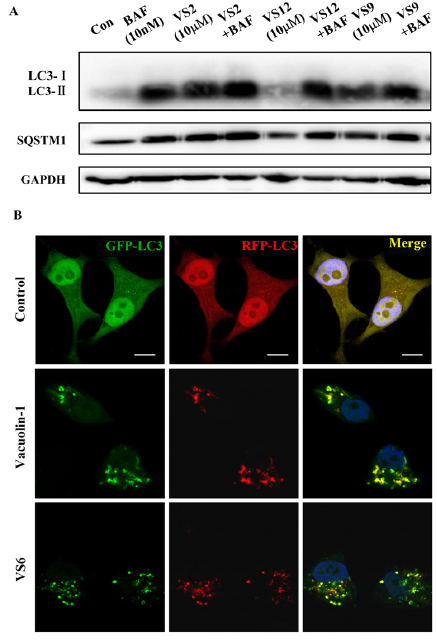
Figure 2. Vacuolin-1 analogues identified via virtual screening inhibited autophagic flux in HeLa cells. ( A ) Treatment of HeLa cells with vacuolin-1 analogues (10 µM) and BAF (100 nM) failed to further increase the accumulation of both LC3B-II and SQSTM1 as compared to either drug alone. ( B ) Vacuolin-1 (10 µM) or VS6 (10 µM) induced the accumulation of yellow LC3B-II puncta in RFP-GFP-LC3B expressing HeLa cells. Scale bar = 10 µm.